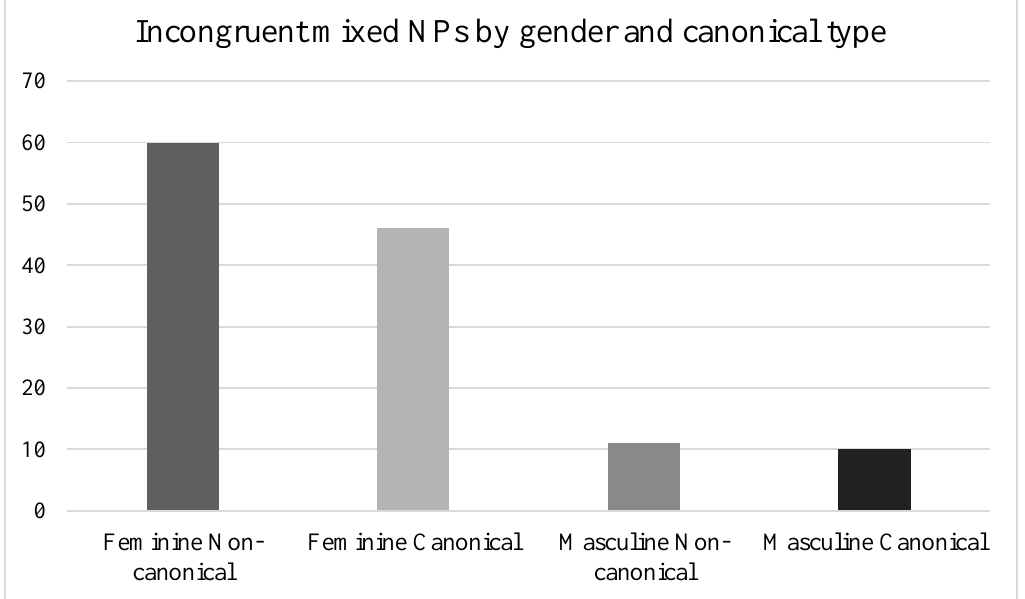
Figure 8. Total number of incongruent mixed NPs by gender and canonical type